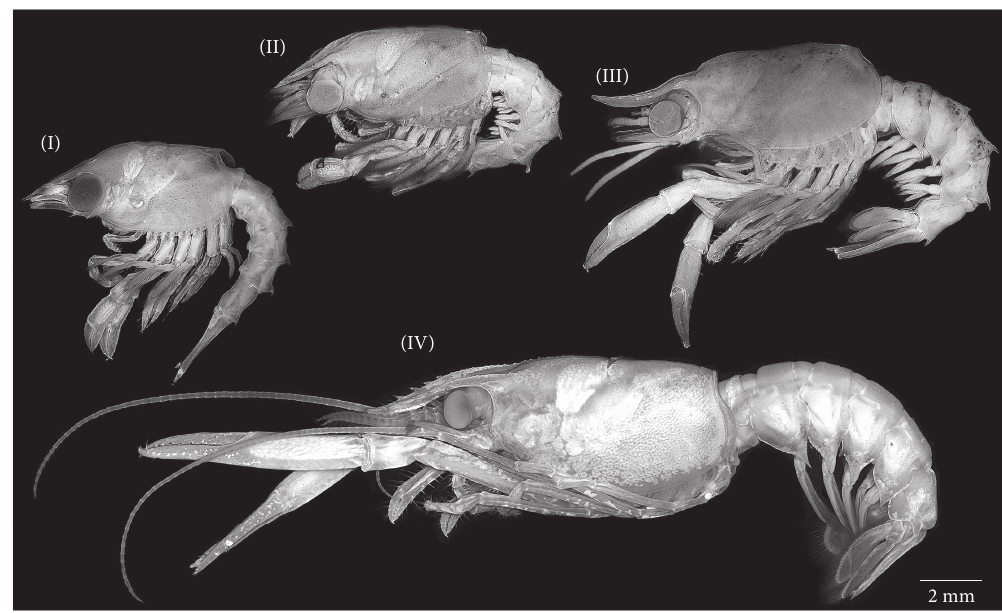
Figure 1: Larval stages of Homarus gammarus labelled with roman numerals. All specimens in lateral view and to the same scale for size comparison.